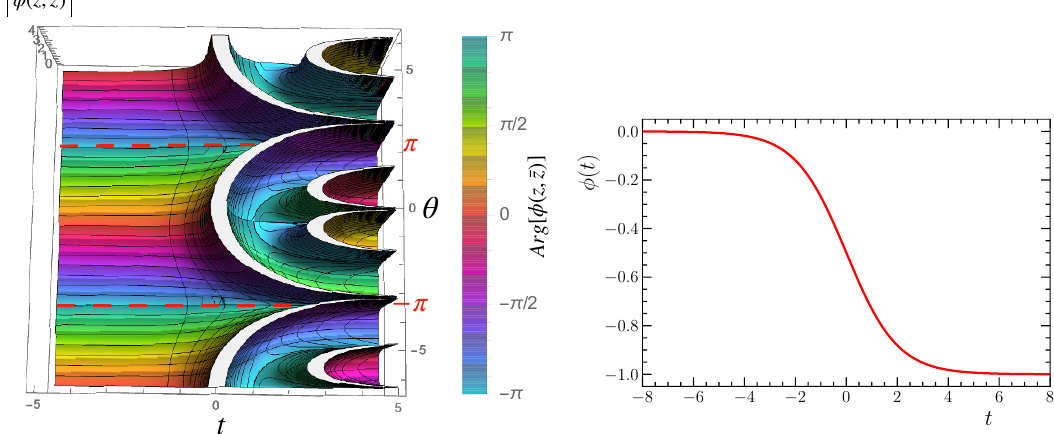
Figure 1 . Plot of the solution in eq. (1.4) when p = 3. In the left panel, the colour bar